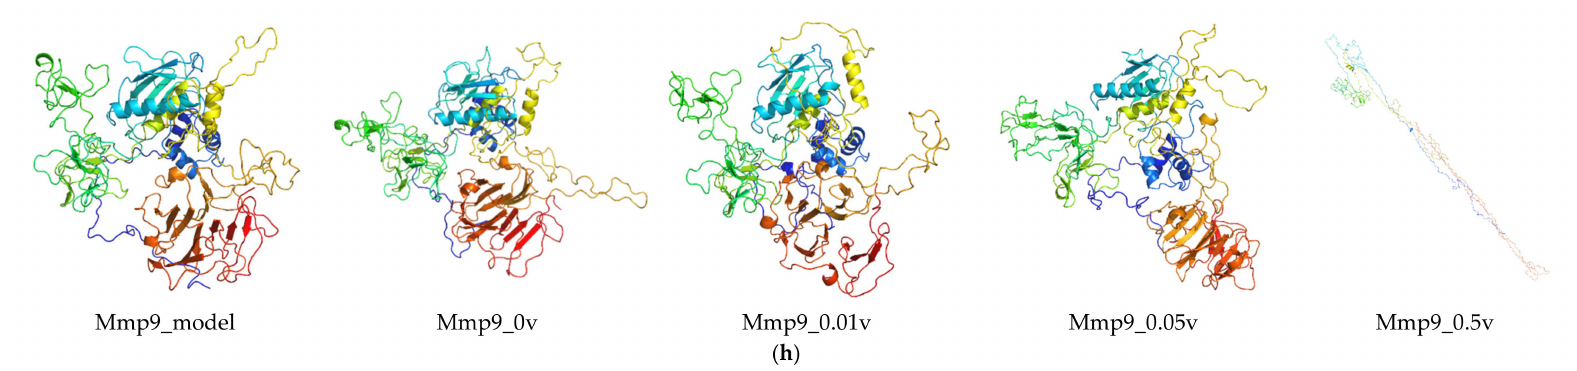
Figure 5. The structure of the three-dimensional protein of DEGs optimized by molecular dynamics. For each protein, from left to right, respectively: three-dimensional protein modeling structure, three-dimensional protein structure of the lowest energy for DEGs after molecular dynamics simulation of 0, 0.01, 0.05, and 0.5 v direct current electric field. Here, the three-dimensional protein structures of Eid3 ( a ), Lrp8 ( b ), Ldlr ( c ), Insig1 ( d ), Fcgr1 ( e ), Ypel3 ( f ), Hcar2 ( g ), and Mmp9 ( h ) are shown. The picture was drawn by the Pymol software (Delano, W.L. The Pymol Molecular Graphics System (2002) DeLano Scientific, SanCarlos, CA, USA. http: //